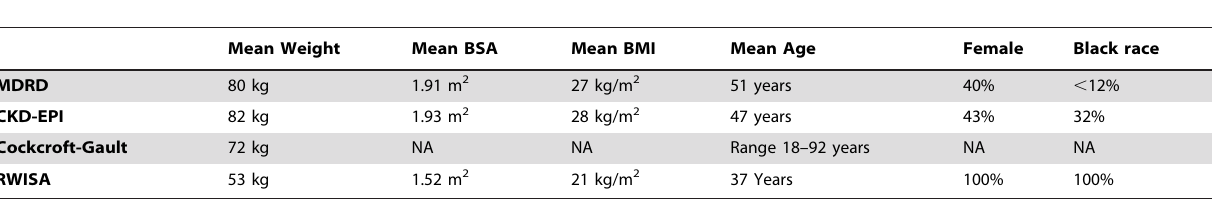
Table 5. Comparison of RWISA participants to the MDRD, CKD-EPI, and Cockcroft-Gault study